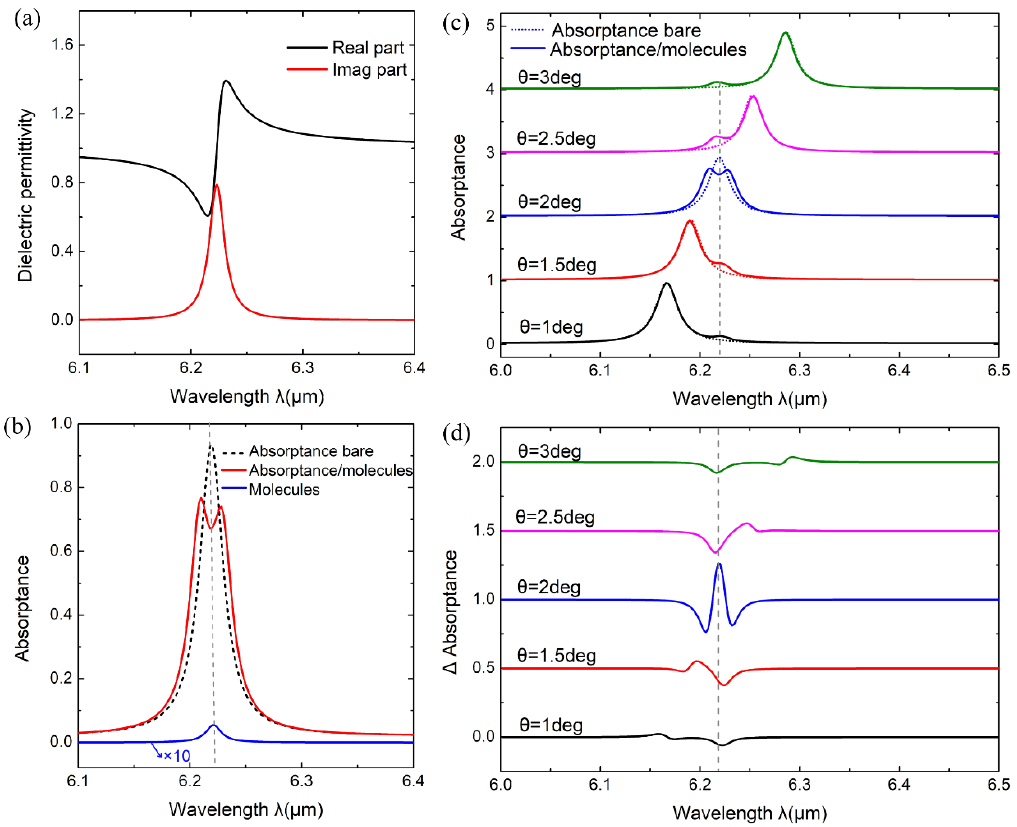
Figure 5. ( a ) The dielectric permittivity of the molecular film with one vibrational mode at 6.225 µ m when N n = 0.1 mol m -3 , γ n = 8 × 10 11 rad / s. ( b ) Absorption spectra of the absorber covered with (solid line) and without (dashed line) 10-nm-thick molecules layer for transverse magnetic (TM)-polarized light with θ = 2 deg. ( c ) Absorption spectra of absorber covered with and without molecules in di ff erent incident angle. ( d ) Delta absorptance of absorber covered with molecules in di ff erent incident angle.